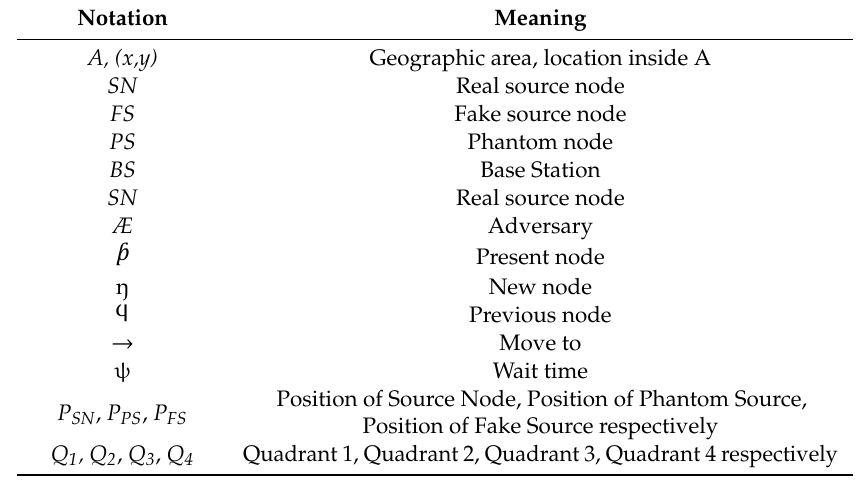
Table 1. Important notations used in this work.